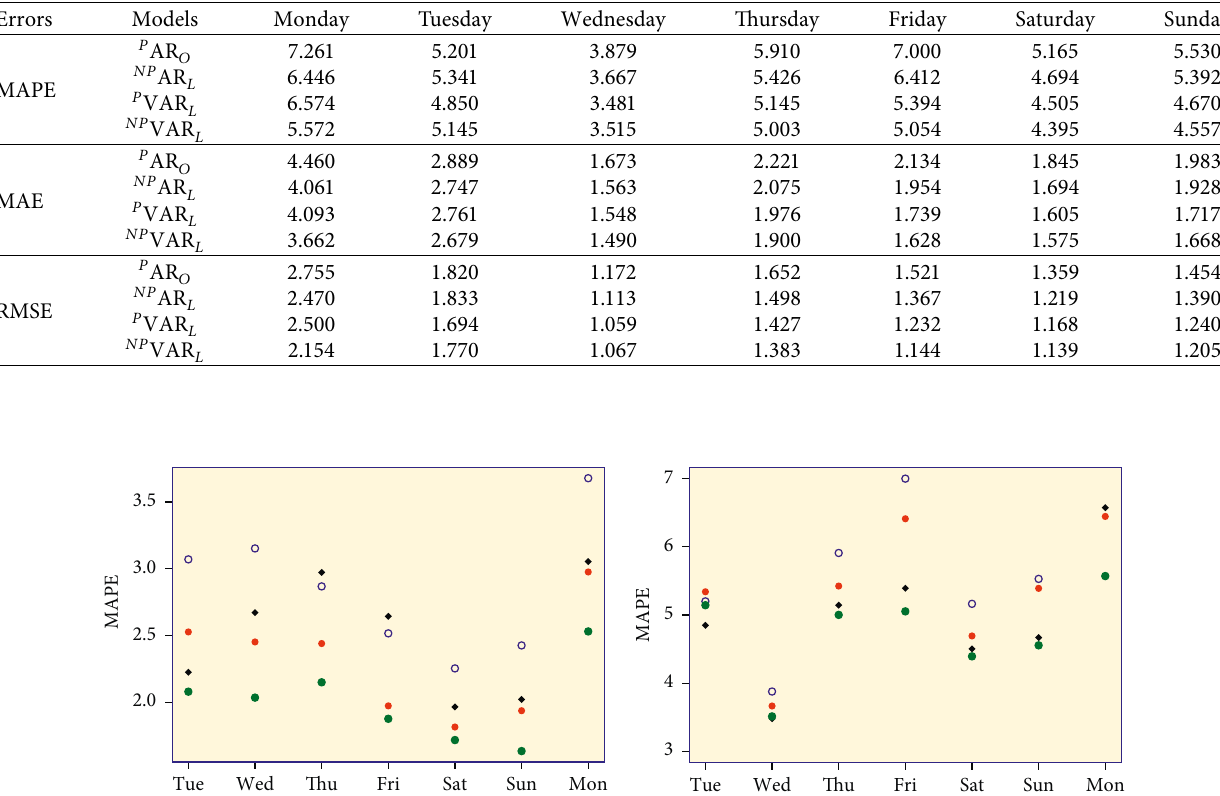
Table 6: Day-specific descriptive statistics for the electricity prices.